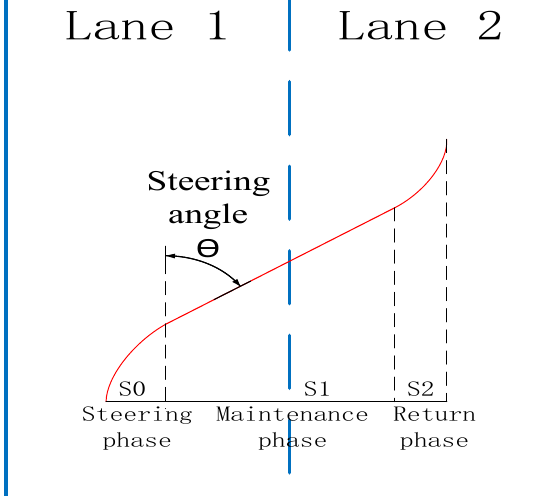
Figure 2. Vehicle lane change diagram.